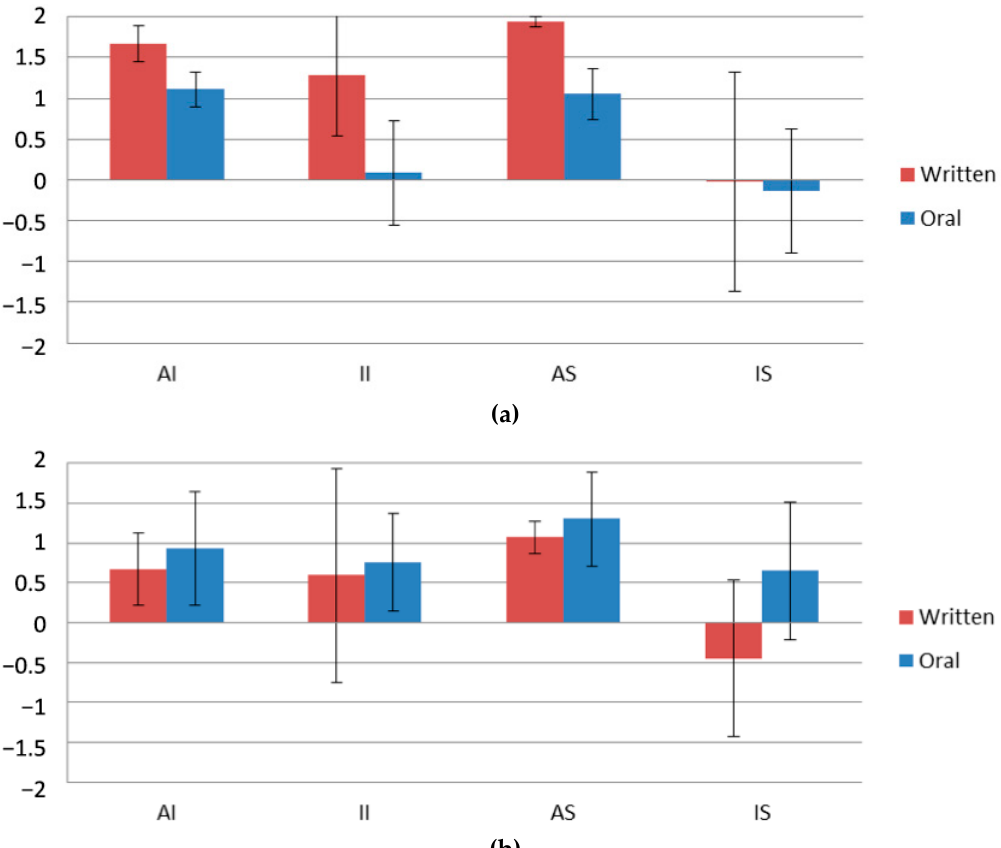
Figure 4. Sentence combination felicity task (written vs. oral), HL results, broken down by subgroup (HLSIM: simultaneous French–Spanish bilinguals, HLSEQ: sequential French–Spanish bilinguals). (a) Task 1 vs. Task 3 (HLSIM); (b) Task 1 vs. Task 3 (HLSEQ).